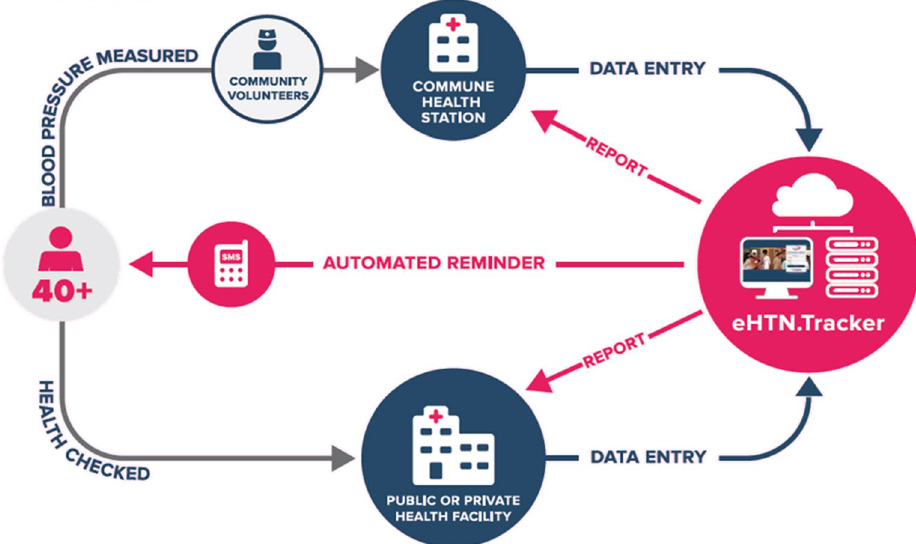
Figure 3. Flow chart of Communities for Healthy Hearts hypertension digital patient registry, the eHTN. Tracker. Source : PATH.